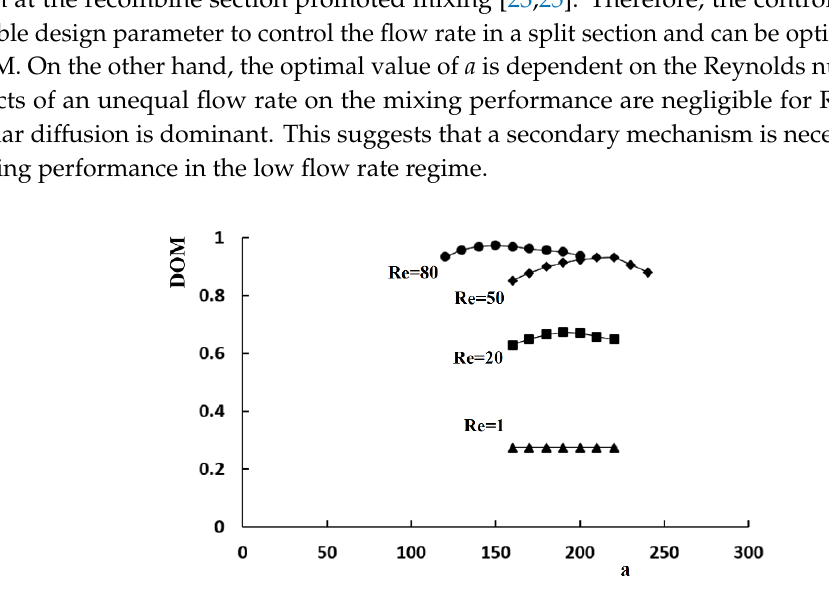
Figure 8. Variation of the DOM with the control parameter, a .